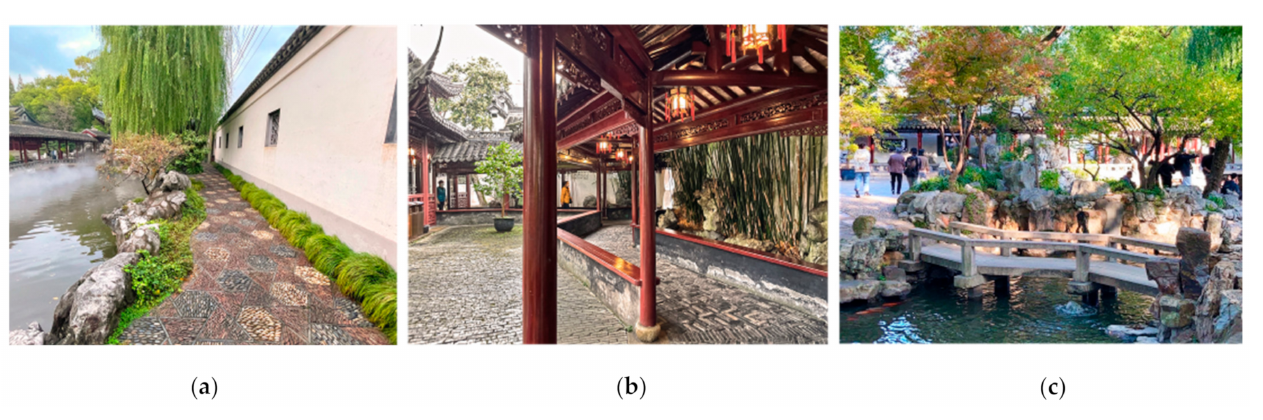
Figure 3. Types of roads in Jiangnan classical gardens: ( a ) garden path; ( b ) corridor; and ( c ) bridge. (Image source: photographed by the